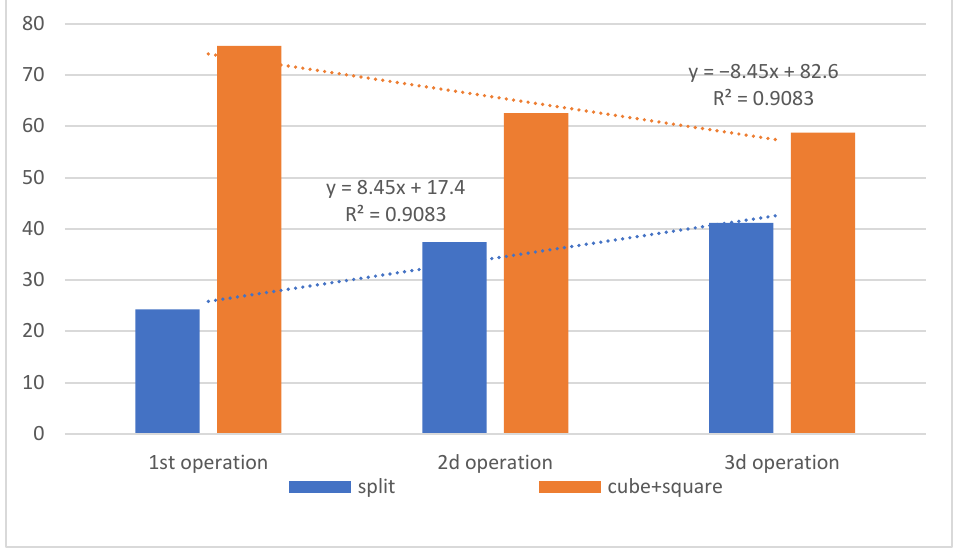
Figure 12. The experimental results: comparison of cubic together with square and spilt fragment forms distribution based on the mean values for the 3rd experiment. Approximating curve shows these changes.